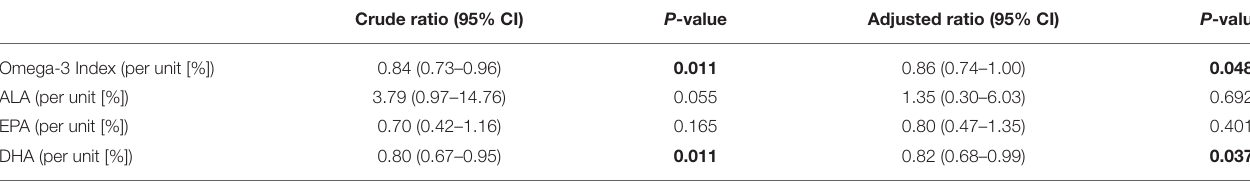
TABLE 2 | Crude and adjusted change in ACR for Omega-3 Index, ALA, EPA and DHA.